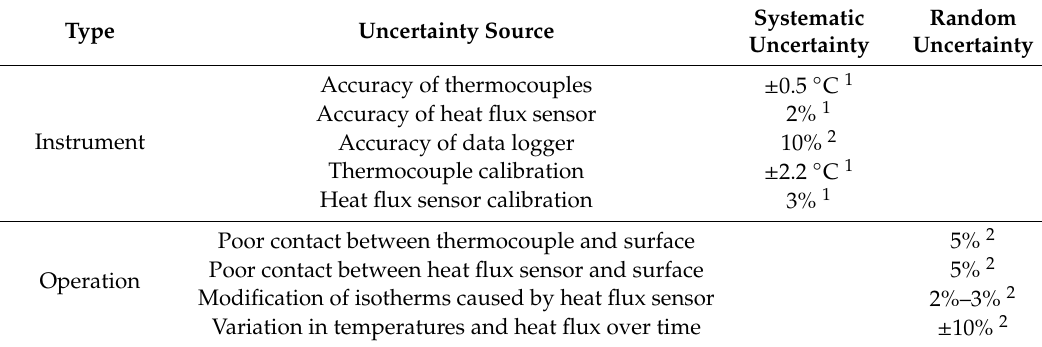
Table 3. Uncertainty sources and their